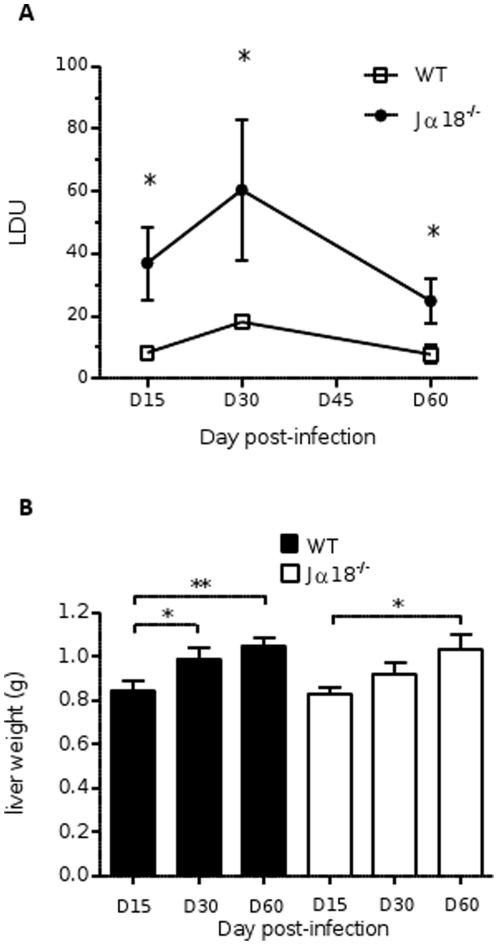
Hepatic parasite burden and liver weight in C57BL/6 WT and Jα18-/- mice after infection with Leishmania donovani.
(A) Liver parasite burden determined on day 15, day 30, and day 60 post-infection by microscopic counting of Giemsa-stained tissue sections, and expressed as LDU (number of parasites/1000 nuclei × liver weight (mg)). (B) Change in liver weight over the course of infection in WT and Jα18-/- mice. Pooled data from two independent experiments (8–10 mice per group).